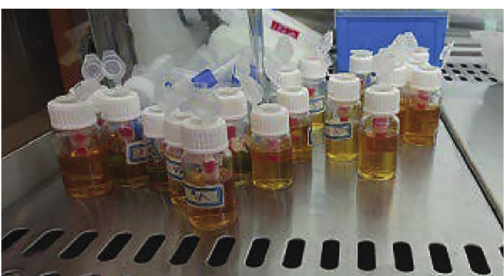
Figure 2: Compressing the upper lacuna (included samples) into lower lacuna (included medium) under sterile conditions until 2- 3mm of the apical areas were placed in BHIB medium.